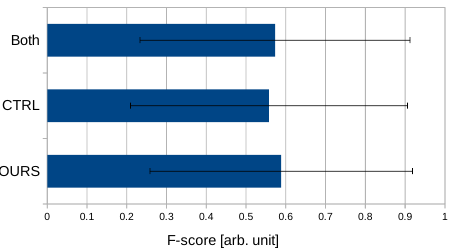
Figure 7. Comparison of F-score between using this work’s NCC (OURS) and another NCC implementation (CTRL), the raw data was obtained from [44]. ’Both’ shows the average and standard deviation of OURS and CTRL